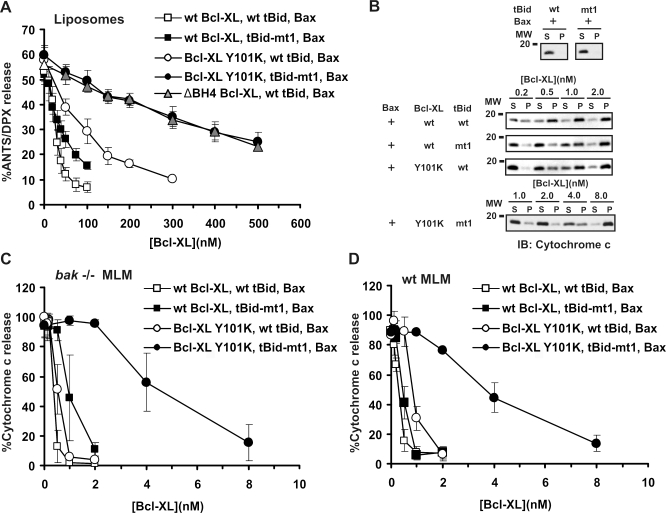
Bcl-XL Binds Both tBid and Bax To Prevent Membrane Permeabilization(A) Liposomes encapsulated with ANTS and DPX were incubated with 100 nM Bax, 20 nM tBid or tBid-mt1, and increasing concentrations of Bcl-XL, Bcl-XL Y101K, or Bcl-XL ΔBH4. Membrane permeabilization was assayed as in Figure 1A and is presented as percentage of ANTS/DPX release mean ± standard deviation for at least three independent experiments.(B) Mitochondria isolated from bak knockout mouse livers (bak –/– MLM) were incubated with 200 nM Bax, 250 pM tBid or tBid-mt1, and increasing concentrations of Bcl-XL or Bcl-XL Y101K, as indicated. Permeabilization was assayed by pelleting the mitochondria and analyzing both the pellet (P) and the supernatant (S) fractions by immunoblotting using an α-cytochrome c antibody.(C) Results from experiments as in (B) quantified as percentage of cytochrome c release mean ± standard deviation for at least three independent experiments.(D) Mitochondria isolated from wild-type mouse livers (wt MLM) were assayed as in (B) except that the concentration of tBid was reduced 10-fold to 25 pM. Permeabilization was quantified as in (C).